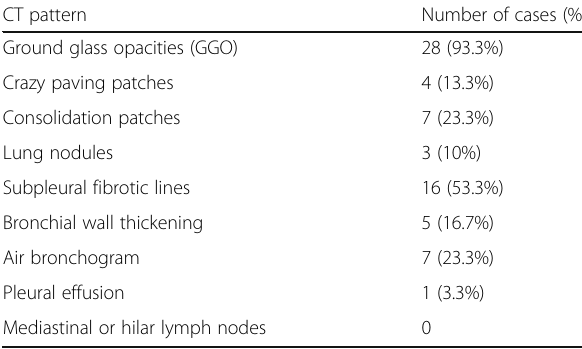
Table 5 Different CT patterns of